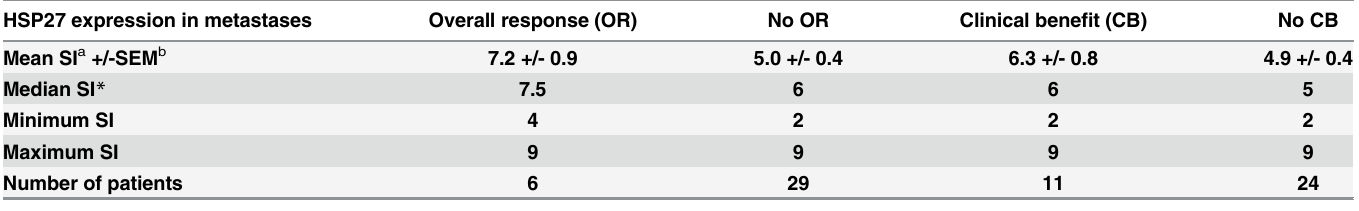
Table 2. Descriptive data for HSP27 expression in metastases. HSP27 expression in metastases Overall response (OR) No OR Clinical bene fi t (CB) No